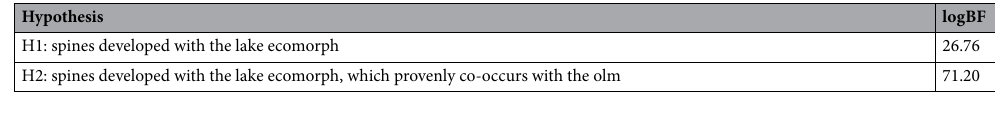
Table 3. Results of phylogenetic analysis of Niphargus ’ traits co-evolution. The hypotheses of spines evolution are evaluated using Log Bayes Factor (logBF). Interpretation of Log Bayes Factor values 26 : < 2 weak evidence, > 2 positive evidence, 5–10 strong evidence, > 10 very strong